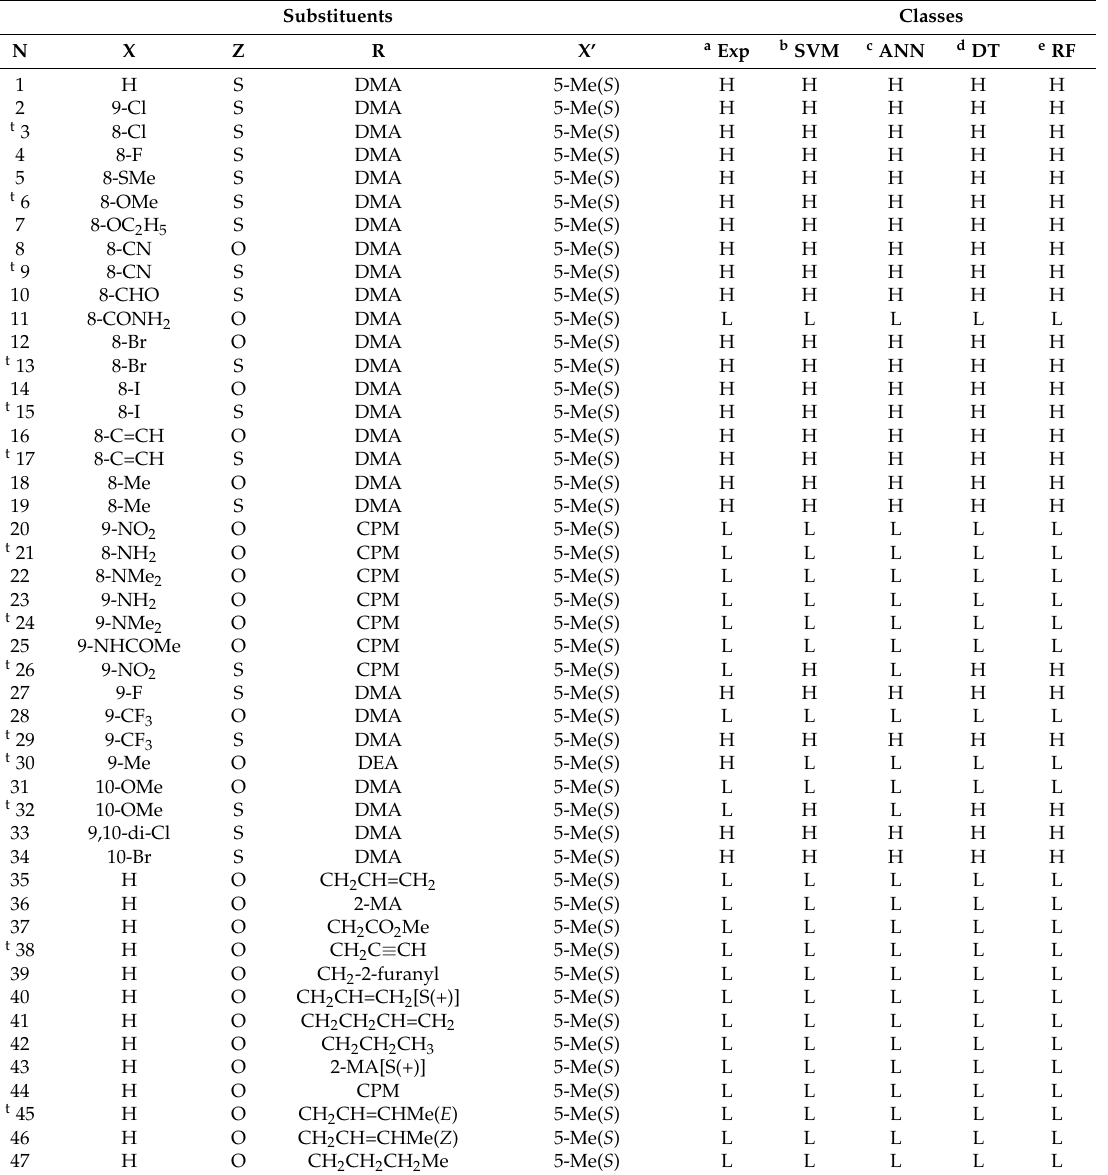
Table 1. Chemical structures of the compounds studied and their anti-HIV activity Substituents